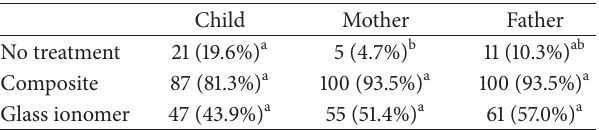
Table 5: Esthetic acceptability of treatment for anterior teeth with mild